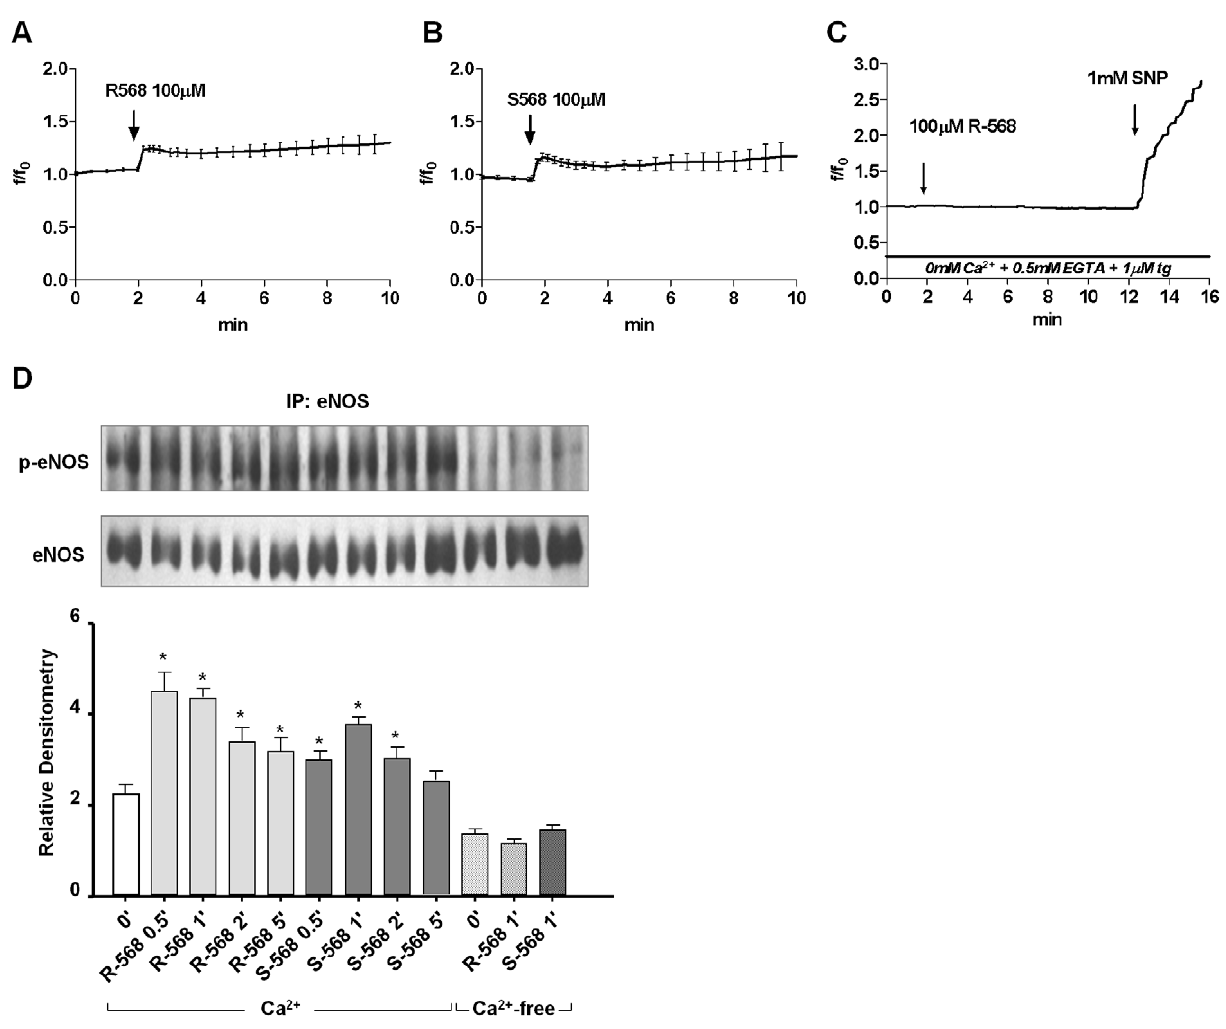
Figure 5. Effects of 100 m M R-568 and S-568 with and without extra and intracellular Ca 2 + on NO production. Intracellular NO levels (mean value 6 SE) in DAF-2DA-loaded HUVECs (A–C). Time effect of R-568 or S-568 100 m M on eNOS-ser1177 phosphorylation (D). Representative immunoblot of eNOS-ser1177 phosphorylation (Upper Panel). Representative data from three experiments (means 6 SD, Lower Panel, p , 0.003 vs 0 9 ). Phospho-eNOS (p-eNOS) was normalized vs eNOS total.